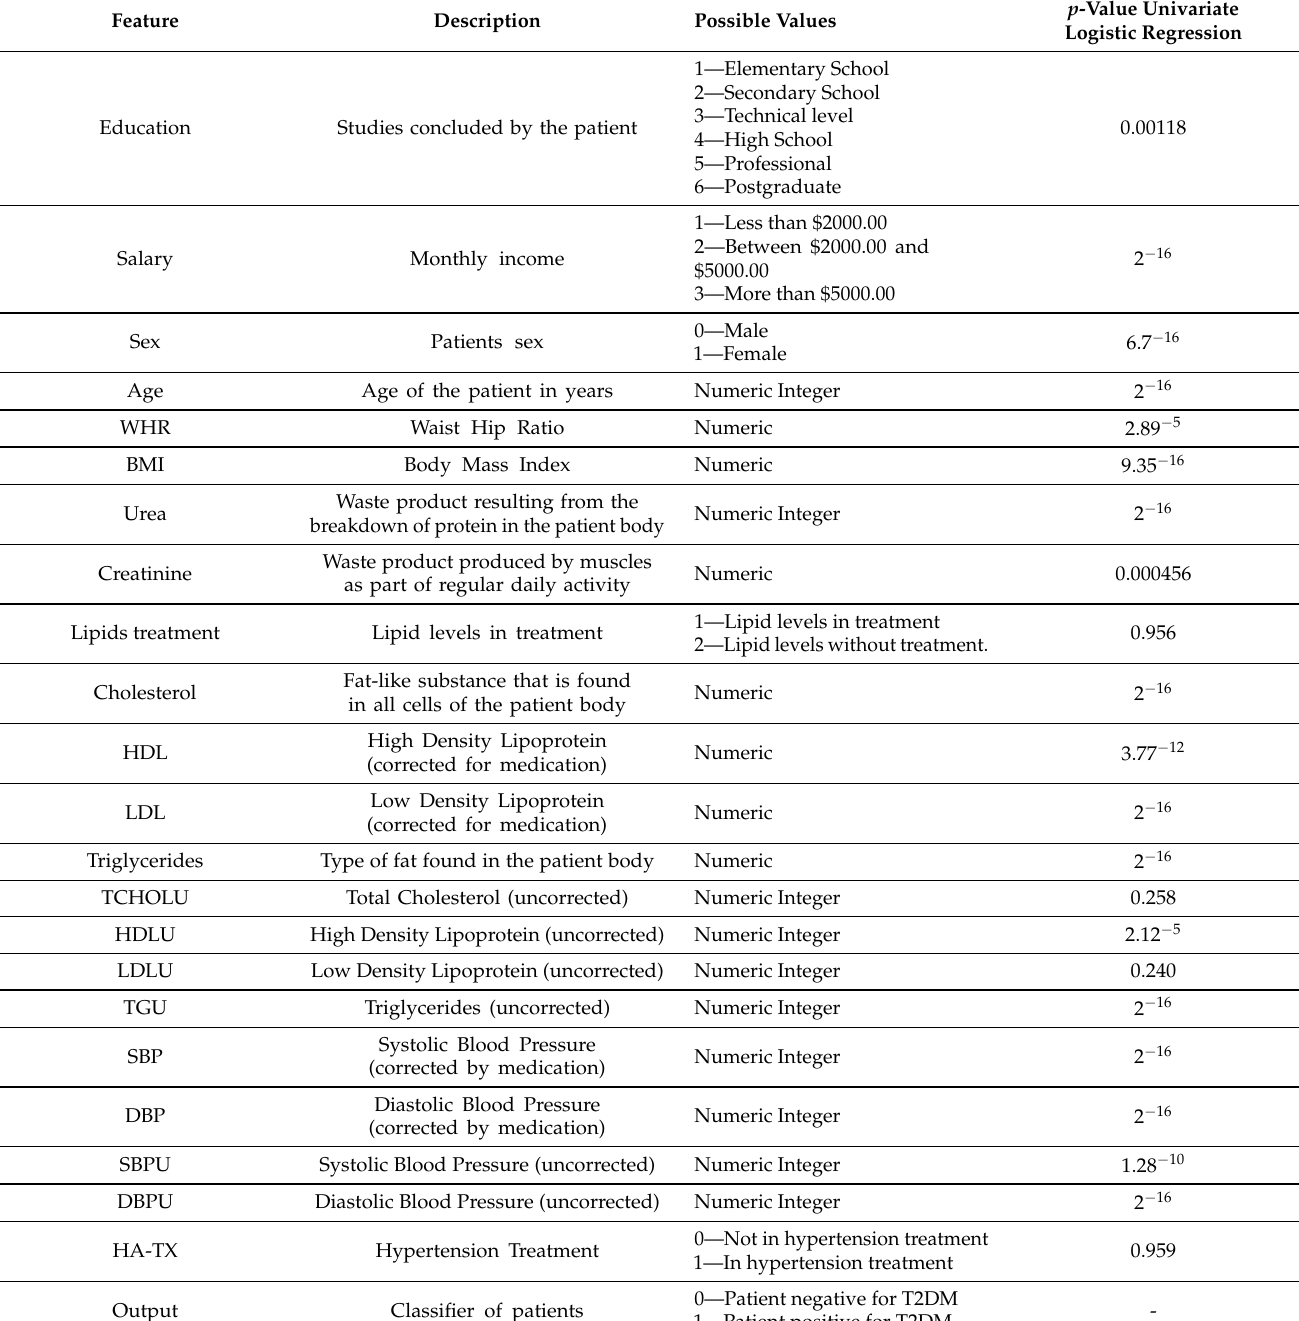
Table 2. Features description and possible